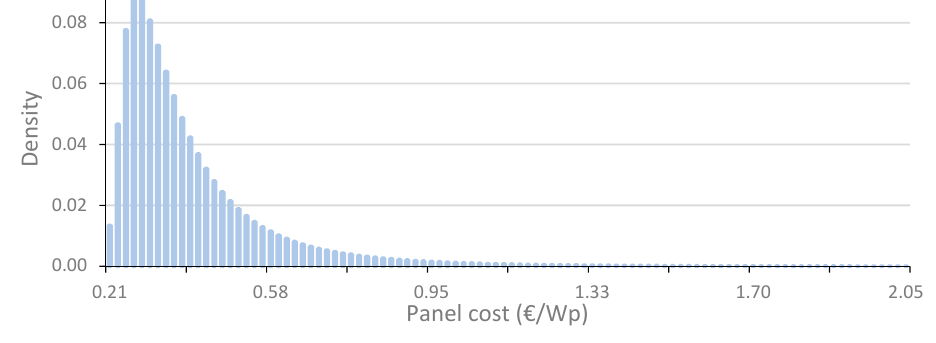
Figure 16. PDF of panel cost for a 500 kW system.